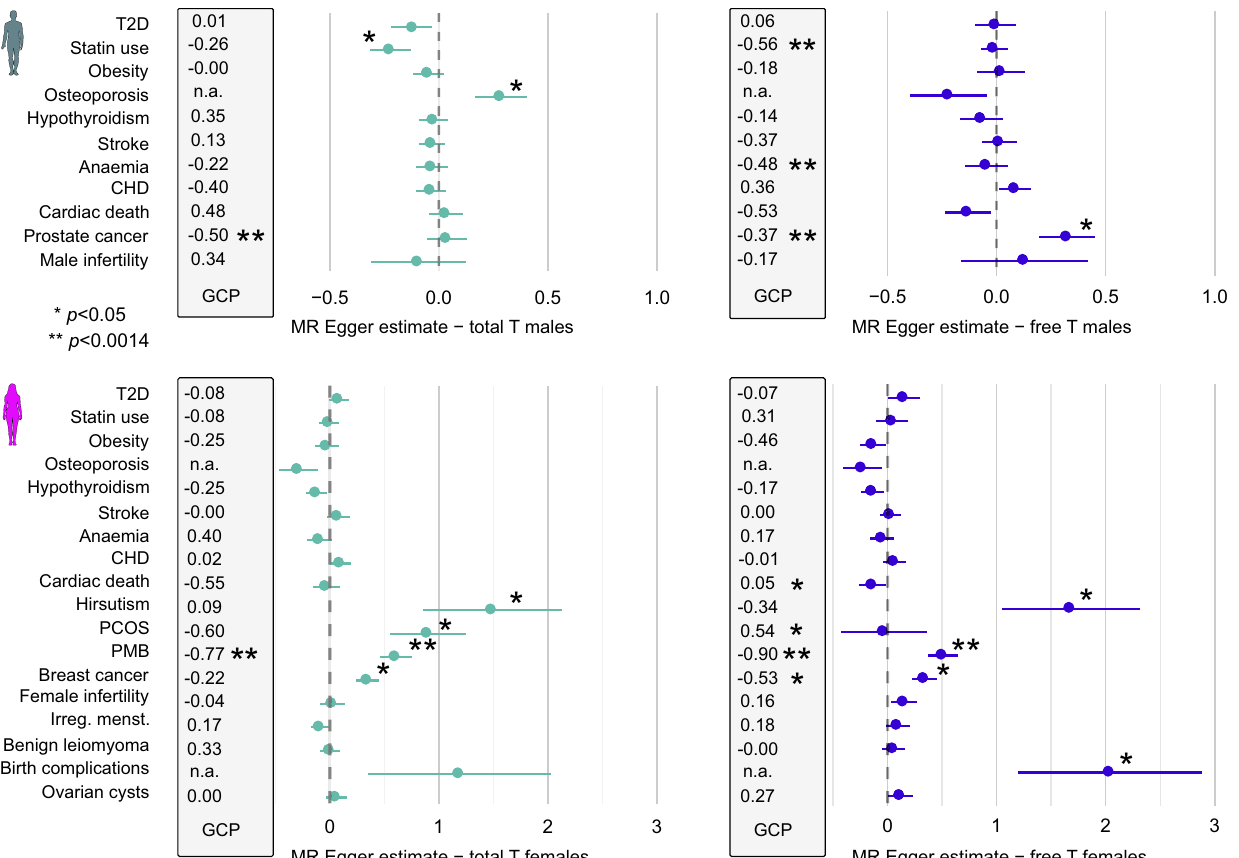
Fig. 3 Results from causality analyses in FinnGen, showing MR estimates for total and free T in males and females. The fi gure includes traits from the endocrine, metabolic, circulatory and sex-speci fi c categories shown in Fig. 2. The data is based on 94,478 men and 122,986 women from FinnGen R5. Case and control numbers for each endpoint are available from Supplementary Data 8. Dark green symbol = males, pink = females. Estimates shown in green = total testosterone, blue = free testosterone. Shown are both genetic causality proportion (GCP) estimates from LCV (within the gray boxes, 0 = no causality, 1 = fully causal, minus sign indicates suggested reverse causality, i.e., the endpoint affecting T), and MR Egger betas and standard error for each trait (horizontal lines). The MR Egger value in the x -axis corresponds to 1 SD increase in risk per 1 SD increase in T/free T. * p < 0.05, ** p < 0.0014, n.a. = not applicable due to low heritability estimate in FinnGen under the LCV